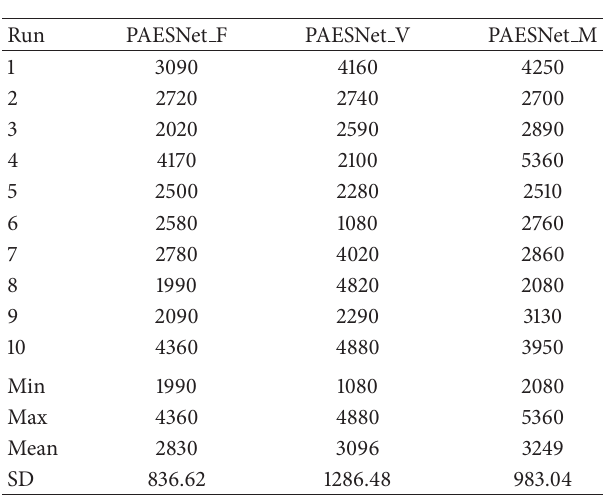
Table 4: The testing results.